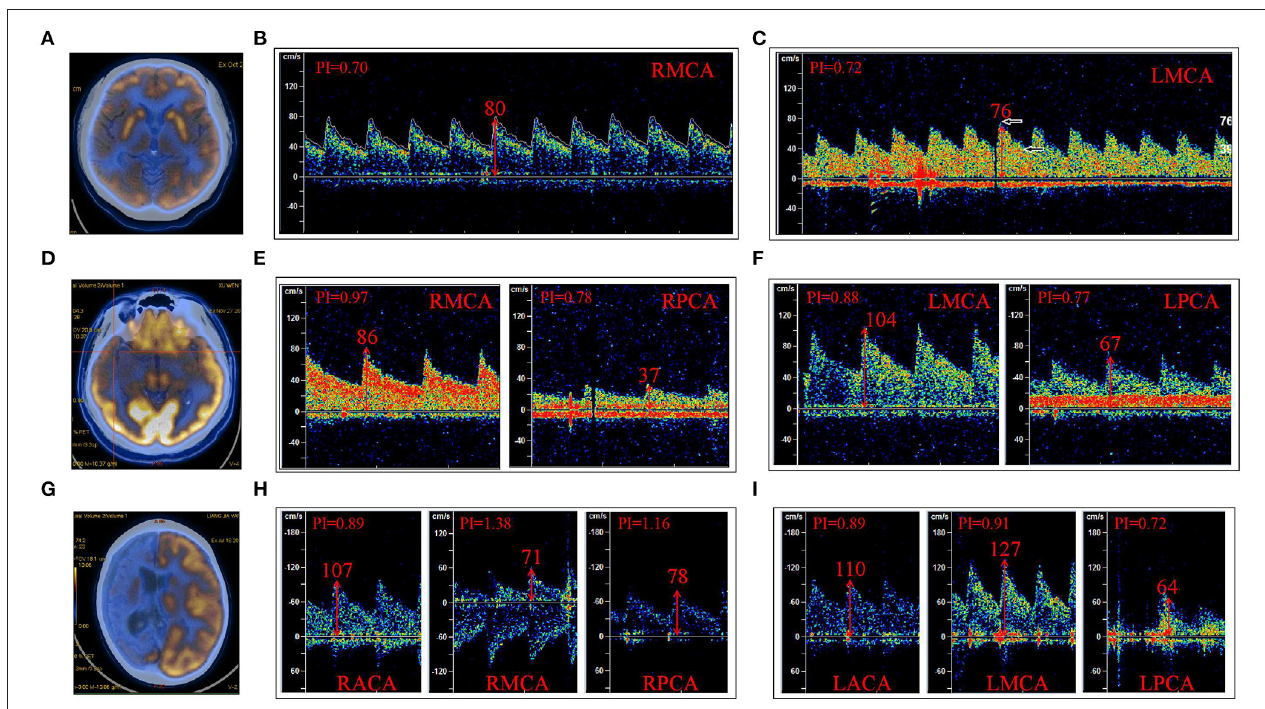
FIGURE 2 | The low metabolic area of FDG 18 -PET-CT (PET) was divided according to the region of the supplying artery. (A) PET indicated a low metabolism in the right frontal and temporal cortex. (B) The PFV of RMCA was 80 cm/s; (C) The PFV of LMCA was 76 cm/s. (D) PET indicated low metabolism in the right temporal lobe and hippocampus; (E) The PFV of RMCA was 86 cm/s, and that of RPCA was 37 cm/s. (F) The PFV of LMCA was 104 cm/s and that of LPCA was 67 cm/s. (G) PET indicated low metabolism in the right cerebral hemisphere. (H) The PFV of RACA, RMCA, and RPCA was 107, 71, and 78 cm/s, respectively. (I) The PFV of